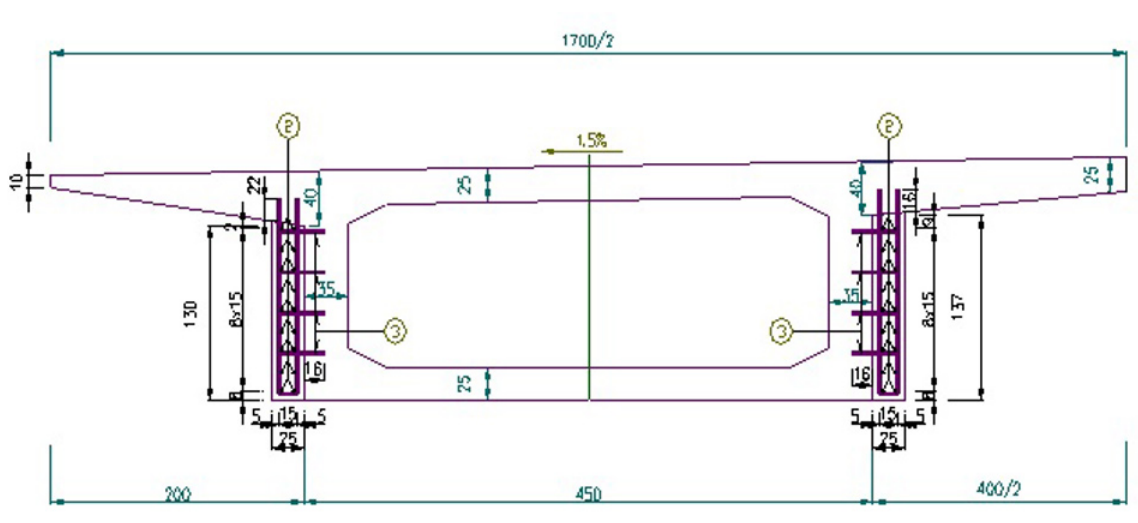
Figure 4. The layout of new additional webs reinforcement